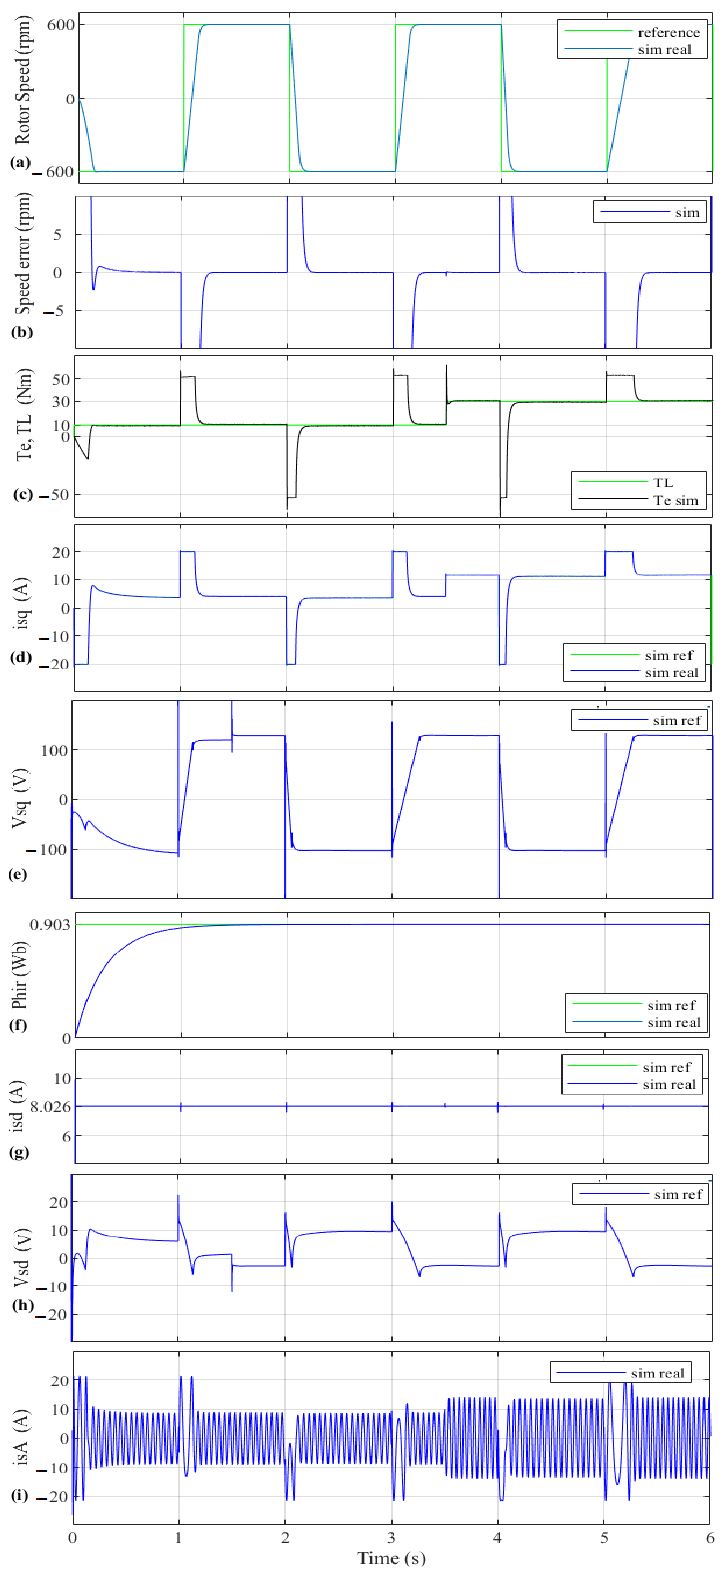
Figure 5. Simulation results with 600 rpm reference speed and two load torque step changes (ISMC D2-T1): ( a ) Rotor speed, ( b ) Speed error, ( c ) T e , T L , ( d ) Torque current, ( e ) v sq , ( f ) Rotor flux, ( g ) Rotor flux current, ( h ) v sd and ( i ) Stator